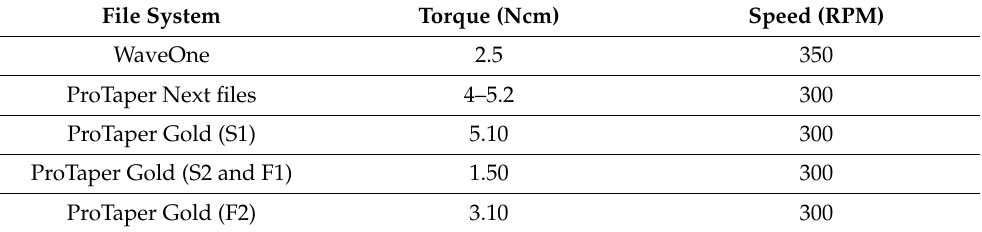
Table 1. Torque and speed of different file systems used.